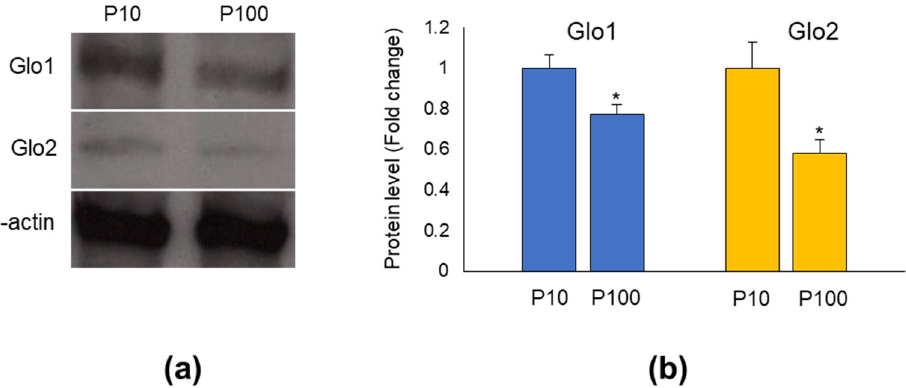
Figure 1. Glyoxalases are cargos of both HASC-P10 and HASC-P100 EVs. ( a ) Representative Western blot (WB) of Glo1 and Glo2; ( b ) quantitative histogram of the relative Glo1 and Glo2 protein expression levels. β -actin was used as internal loading control for WB normalization. The WB bands of Glo1 and Glo2 were quantified by densitometric analysis, normalized against β -actin, and expressed as relative protein level (fold change). The histograms indicate the mean ± SD of three independent experiments. * p < 0.05 vs. P10.